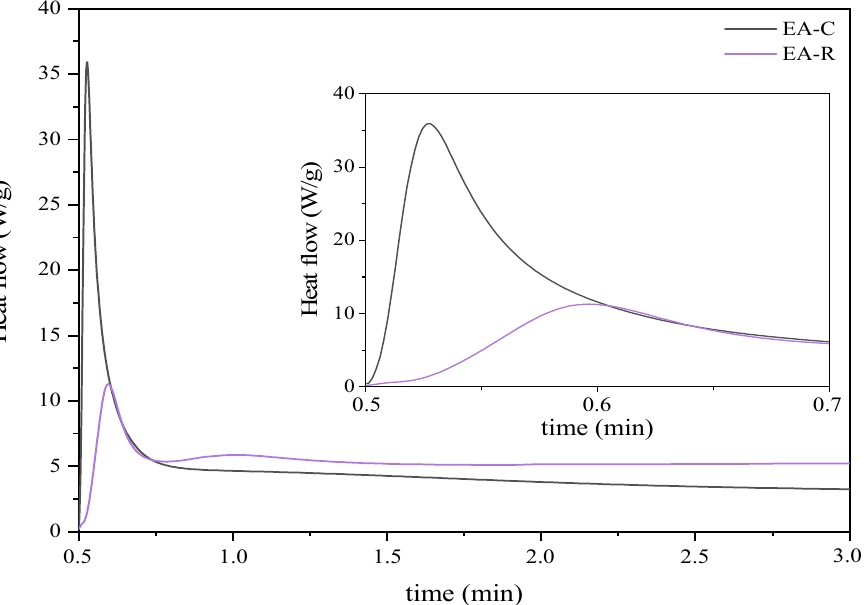
Figure 5. Photo-DSC thermograms corresponding to the cationic (EA-C) and radical (EA-R) photocuring behavior (photo-DSC method; mercury UV lamp, 280–480 nm, 100 mW/cm 2 ; composition of the photoreactive formulations: 96 wt% of EA prepolymer, 4 wt% of cationic or radical PI).